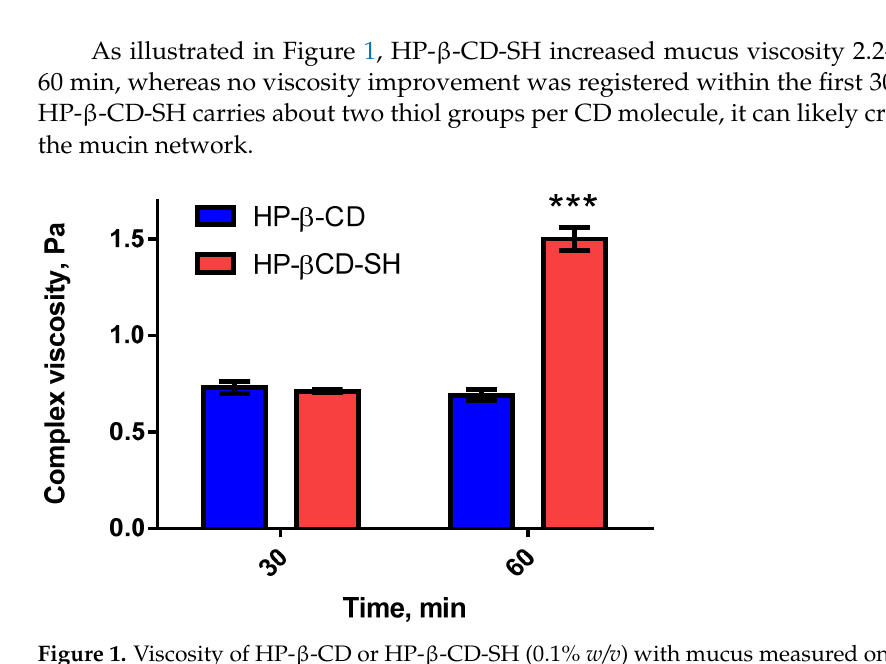
Figure 1. Viscosity of HP- β -CD or HP- β -CD-SH (0.1% w/v ) with mucus measured on a plate-plate viscometer (1 Hz frequency). Each point is the mean ± standard deviation (SD) of at least three values (*** p < 0.001).